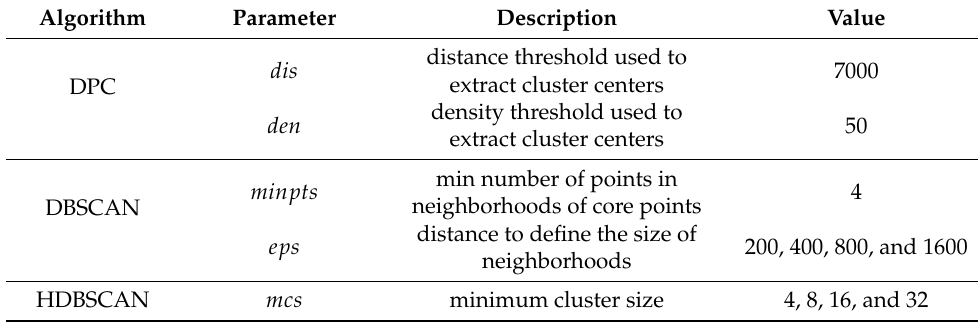
Table 2. Parameters with their descriptions and values of the three